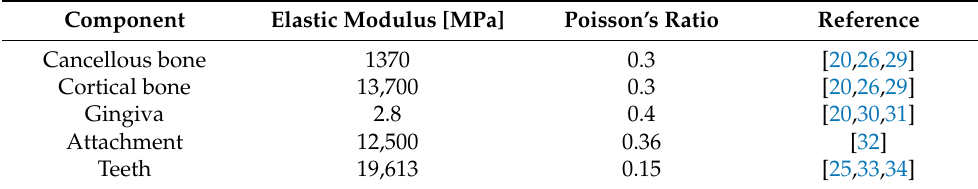
Table 1. Material properties of the linear components of the FE model.